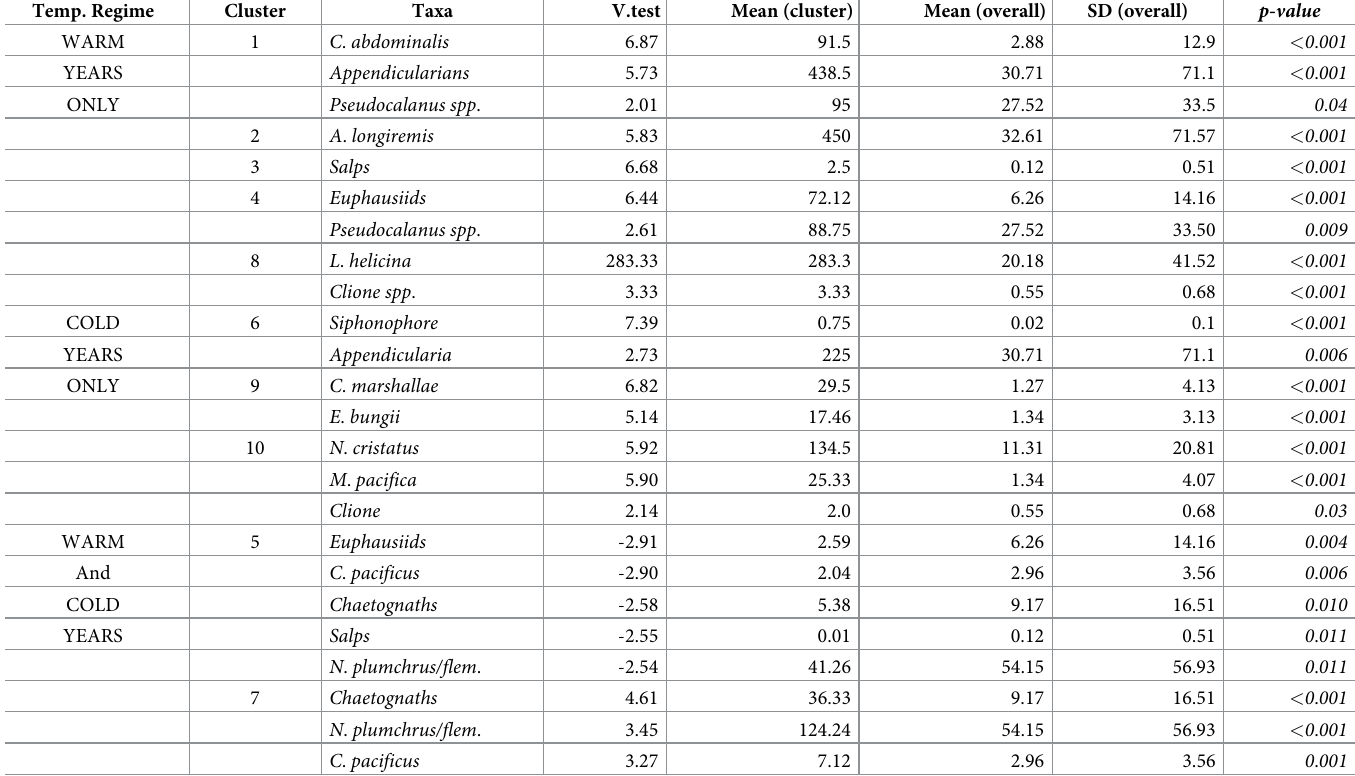
a The means and standard deviations of each taxon within its cluster is shown, along with its positive (+) or negative (-) relationship compared to its background abundance in all other